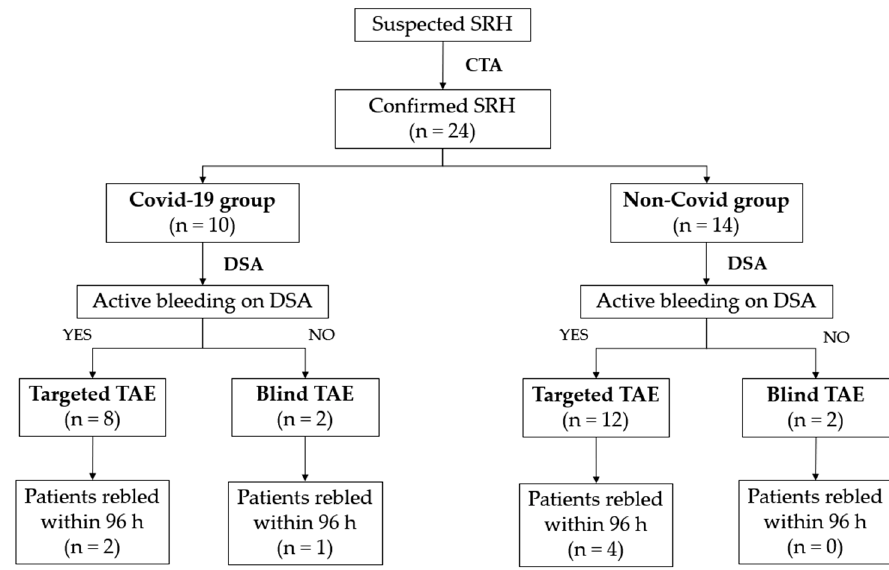
Figure 3. Patient Figure 3. Patient flowchart. Table 3. Comparative results between COVID-19 and non-COVID-19 groups.